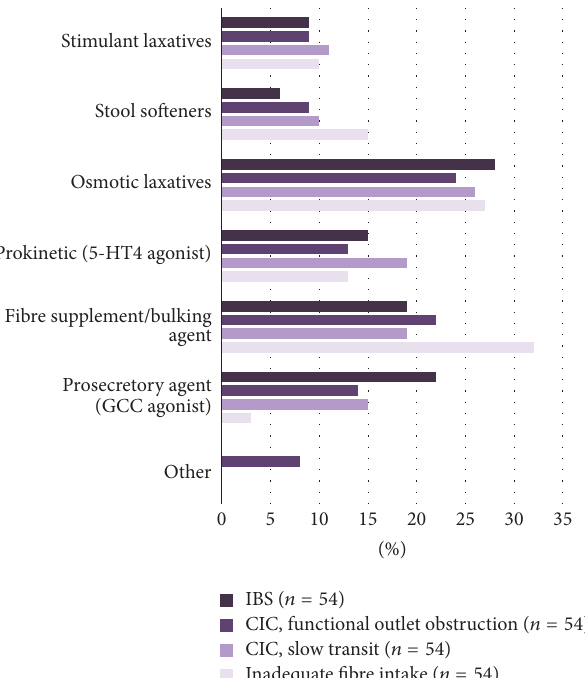
Figure 1: Types of treatment patients would ideally receive based on the type of chronic constipation (the Appendix: Question ( 4 )). Osmotic laxatives were ranked as first-line treatment for both CIC and IBS-C, followed by fibre supplements/bulking agents being second-line treatment for CIC and GCC agonist being second-line treatment for IBS-C. (CIC : chronic idiopathic constipation; IBS-C : constipation-predominant irritable bowel syndrome; GCC : guanylyl cyclase C)